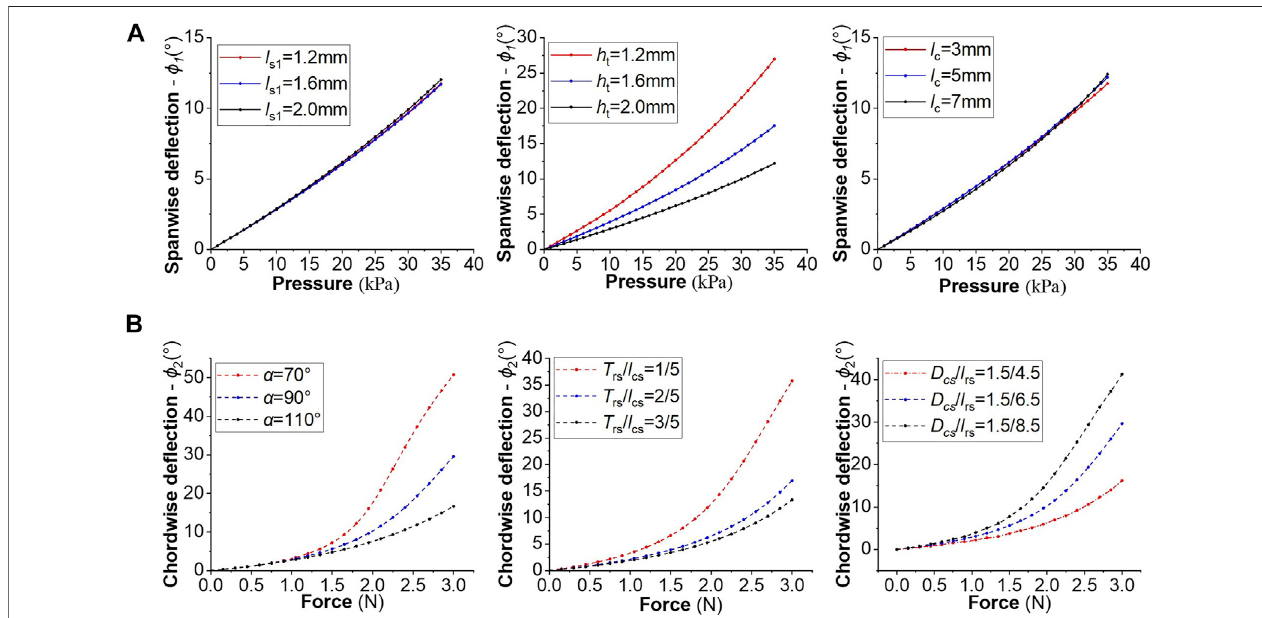
FIGURE 6 | Design optimization of spar and ribs by FEM. (A) Spanwise bending angle of spar corresponding to different applied pressures; (B) Chordwise de fl ection of ribs corresponding to different applied cable forces.